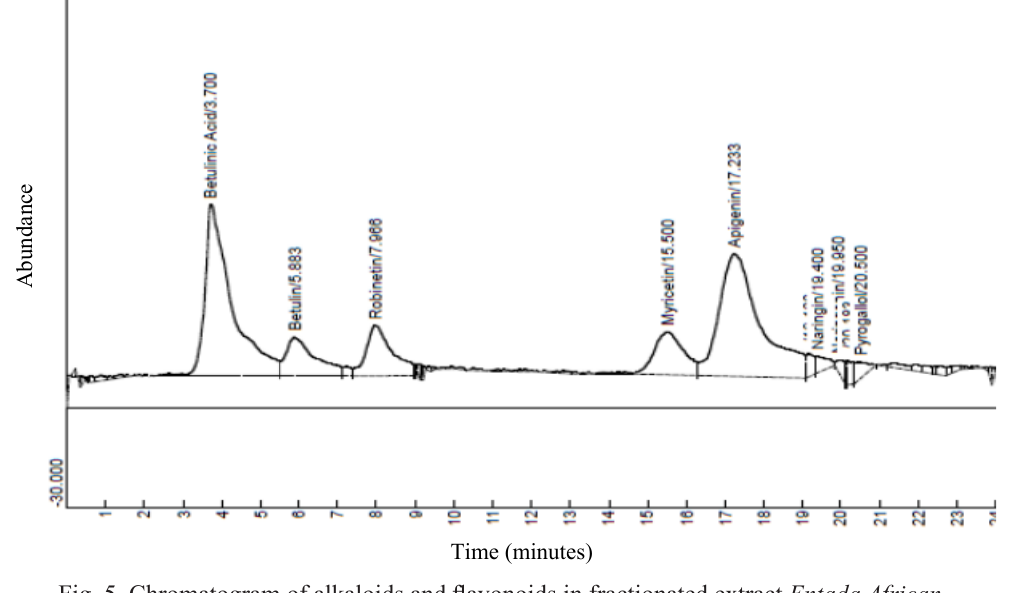
Fig. 5. Chromatogram of alkaloids and flavonoids in fractionated extract Entada